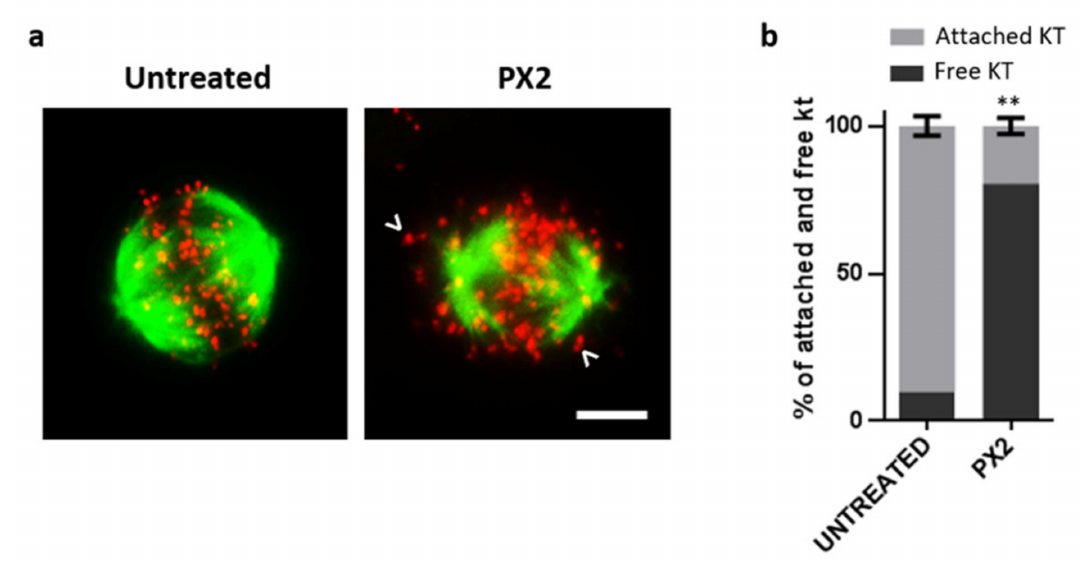
Figure 4. Pyranoxanthone 2 (PX2) treatment generates loss of stability of kinetochore-microtubule attachments. ( a ) Representative immunofluorescence images after cold treatment assay, showing several unattached kinetochores (free red spots pointed by the white arrowheads) in cells with PX2 treatment, whereas most kinetochores were attached (Red spots with attached green fibers) in untreated cells. Microtubules (green) were stained with anti- α -tubulin antibody, kinetochores (red) with anti-CREST antibody, and DNA (blue) with DAPI. ( b ) Quantification of cold-stable microtubules (as percentage of attached kinetochores per cell) after treatment with PX2 with statistical relevance of ** p < 0.01 by unpaired t